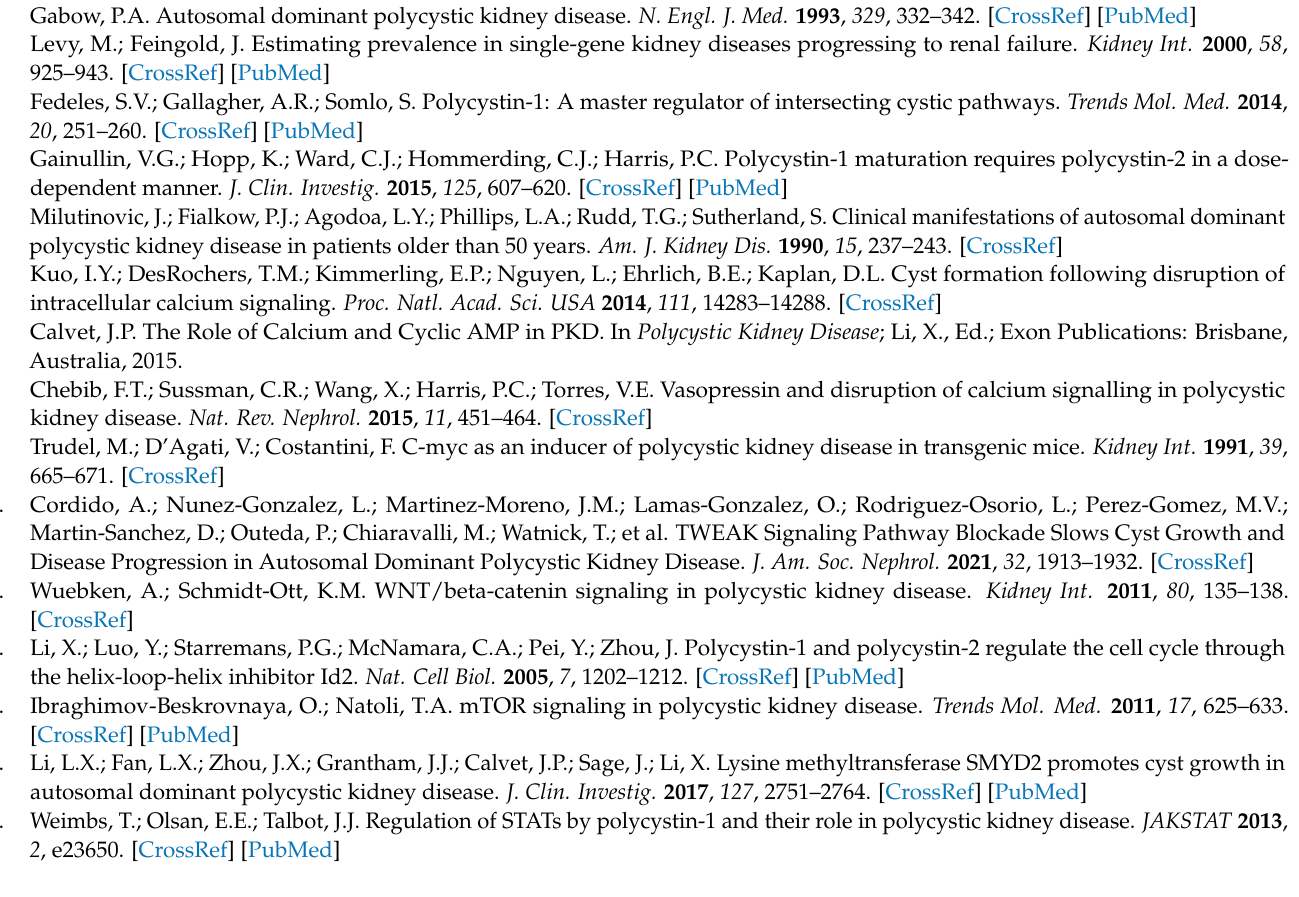
expressed genes in fibroblast cells at day 7; Table S5. The list of differentially expressed genes in fibroblast cells at day 14; Table S6. The list of differentially expressed genes in fibroblast cells at day 21; Table S7. The list of differentially expressed genes in macrophages at day 7; Table S8. The list of differentially expressed genes in macrophages at day 14; Table S9. The list of differentially expressed genes in macrophages at day 21; Table S10. The list of differentially expressed genes in NK and T cells at day 7; Table S11. The list of differentially expressed genes in NK and T cells at day 14; Table S12. The list of differentially expressed genes in NK and T cells at day